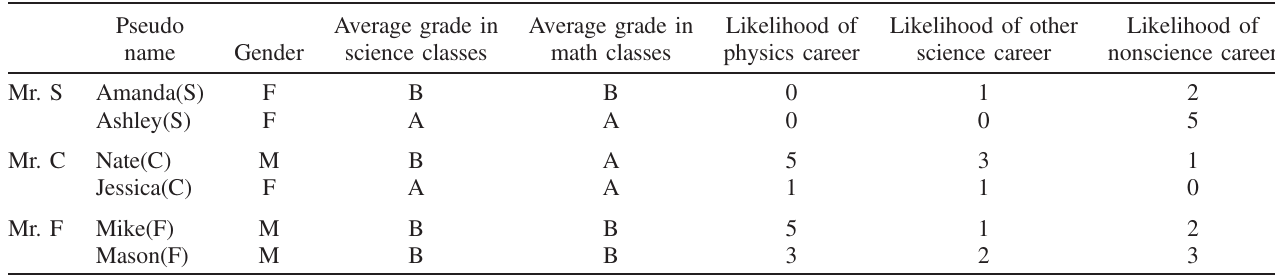
TABLE III. Interviewees ’ background